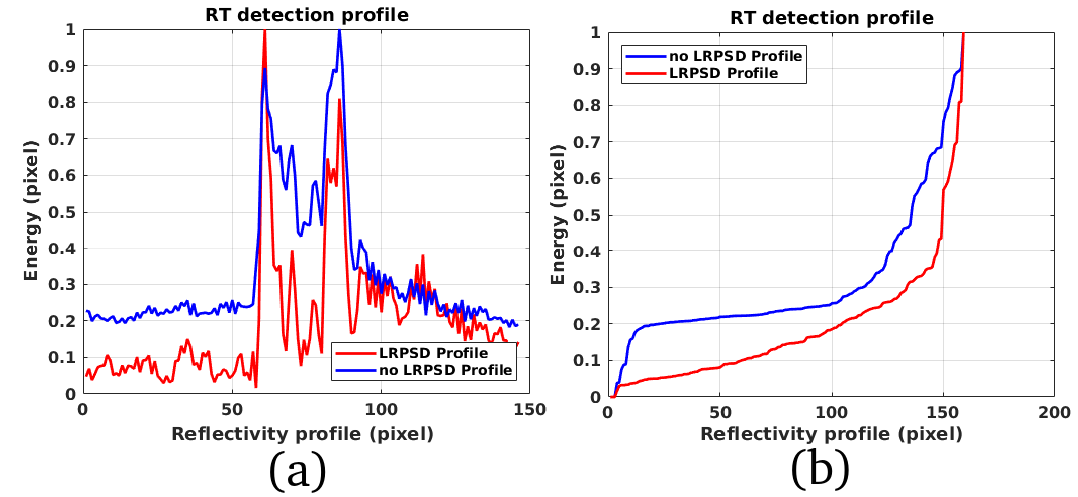
Figure 11. ( a ): Reflectivity profiles. ( b ): Receiving operating characteristic (ROC) curve.